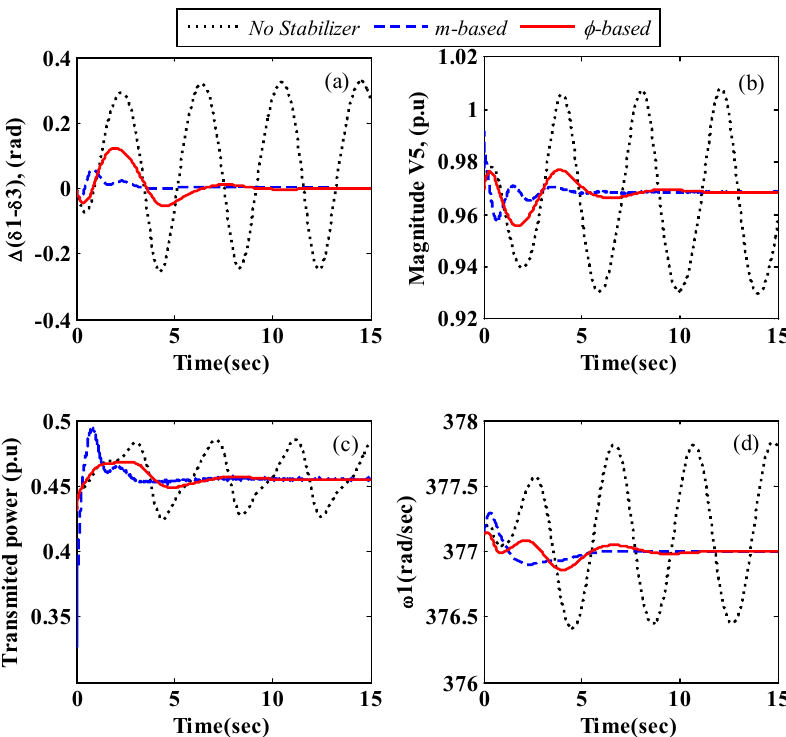
Figure 15. Nonlinear simulations in heavy loading using a robust-based stabilizer designed by the hGWO-GA algorithm (( a ) angle difference between G 1 and G 3 , ( b ) magnitude of voltage bus 5, and ( c ) transmitted power between area1 and area2, ( d ) rotor speed of generator G1).